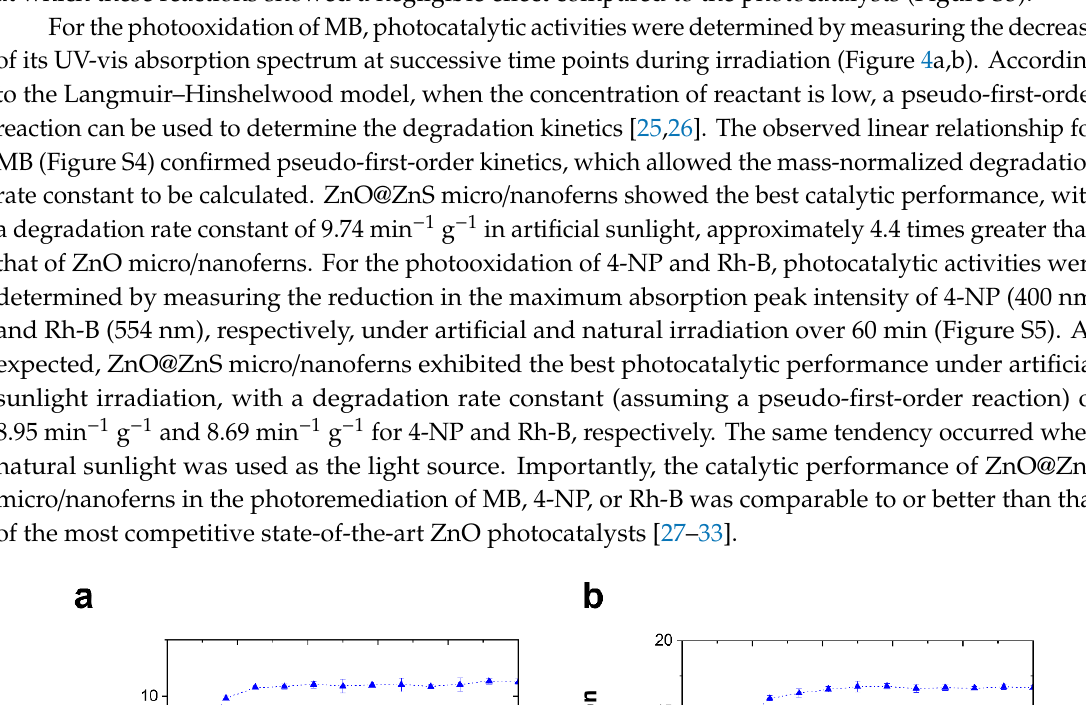
Figure 3. ( a ) UV-vis DRS absorption spectra and ( b ) Tauc plots from the UV-vis analysis of ZnO and ZnO@ZnS(4 h) micro/nanoferns.